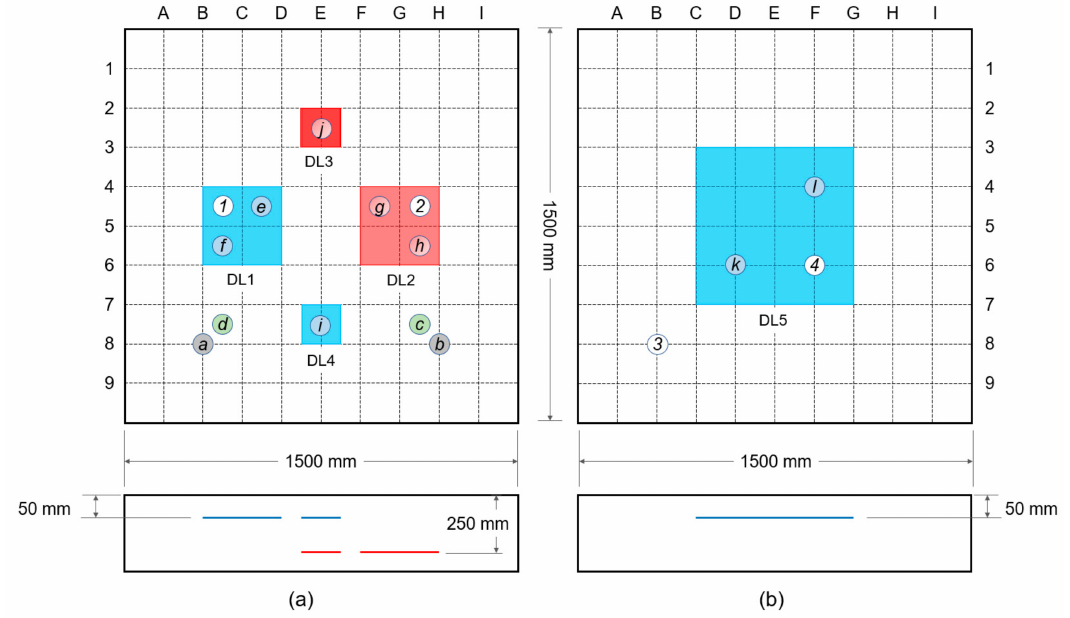
Figure 3. Reinforced concrete slabs with artificial delamination defects with di ff erent sizes and depths: ( a , b ) concrete slab specimens 1 and 2,